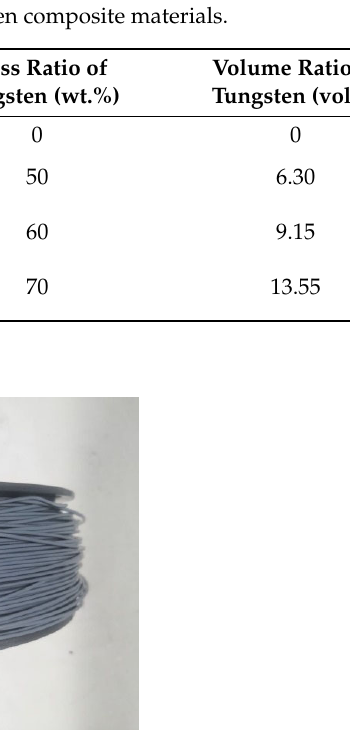
Table 1. Material ratios of PEEK/tungsten composite materials.